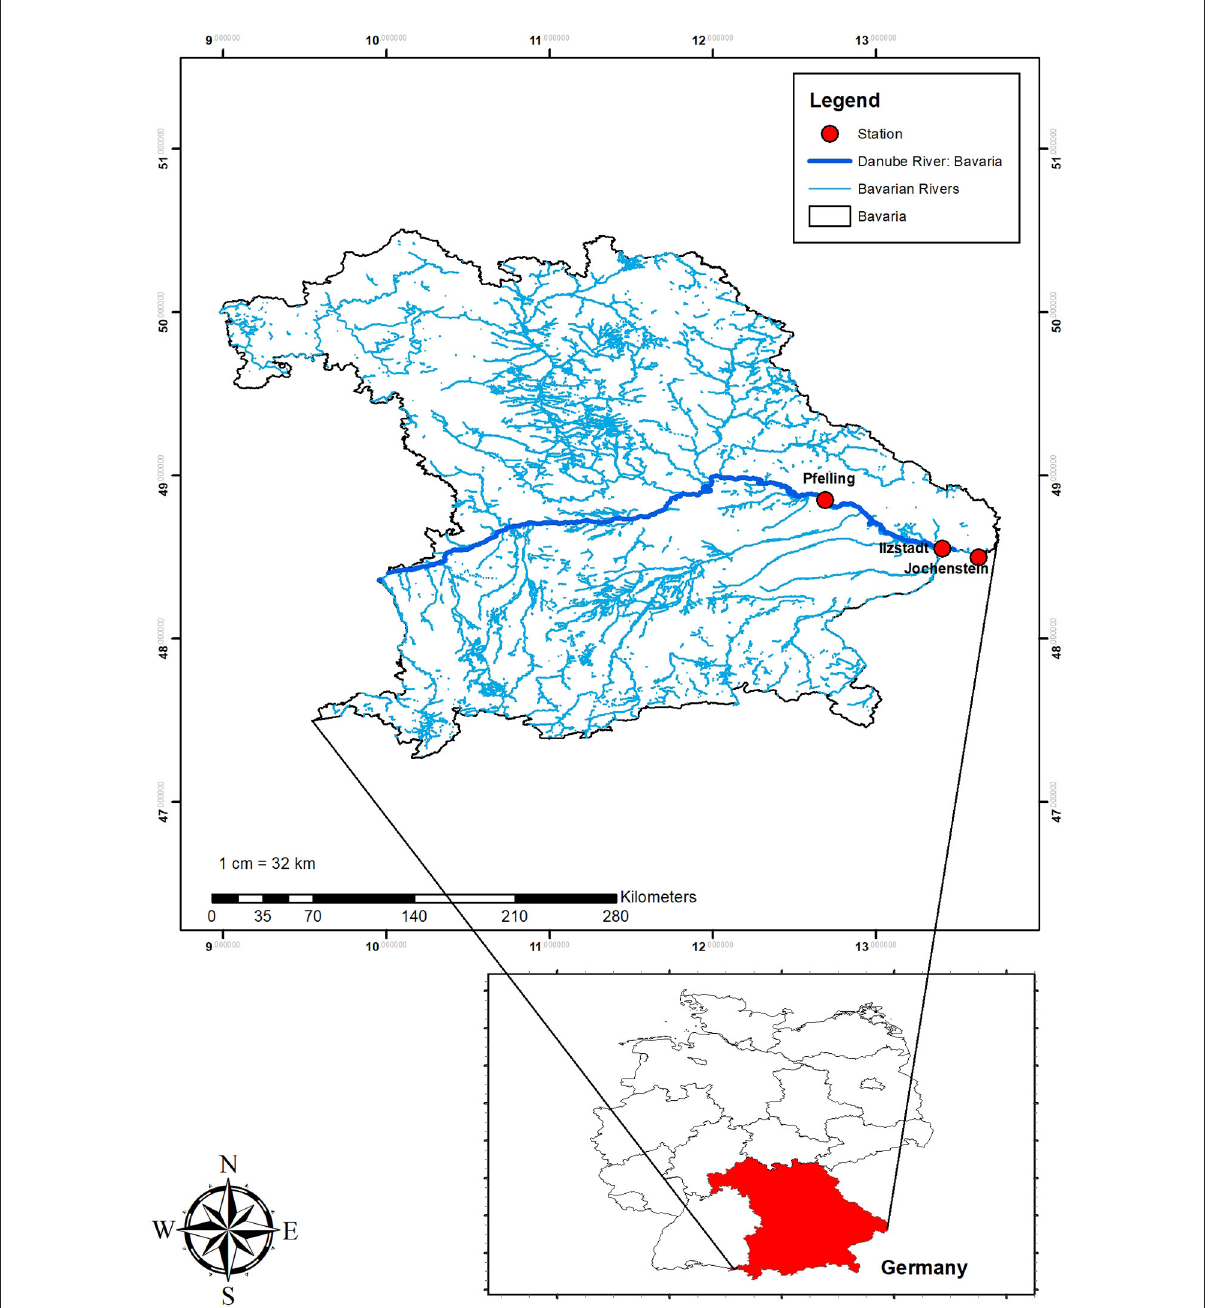
FIGURE1 Locations of automatic measurement stations on Danube